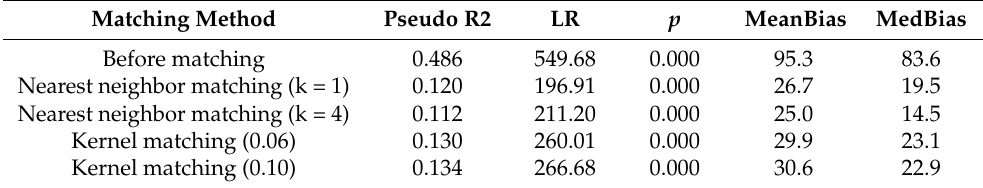
Table 8. Balance test results of explanatory variables before and after matching.